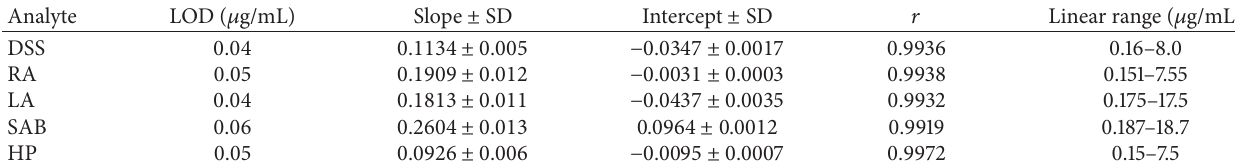
Figure 2: Typical HPLC chromatograms of the analytes in rats plasma. (a) Chromatogram of blank plasma; (b) chromatogram of standards; (c) blank plasma spiked with DSS, RA, LA, SAB, HP, and IS; and (d) chromatogram of a plasma sample at 10min after oral administration of a combination of both extracts. Peak 1: DSS; peak 2: HP; peak 3: IS; peak 4: RA; peak 5: LA; and peak 6: SAB. Table 1: Calibration curves of the five